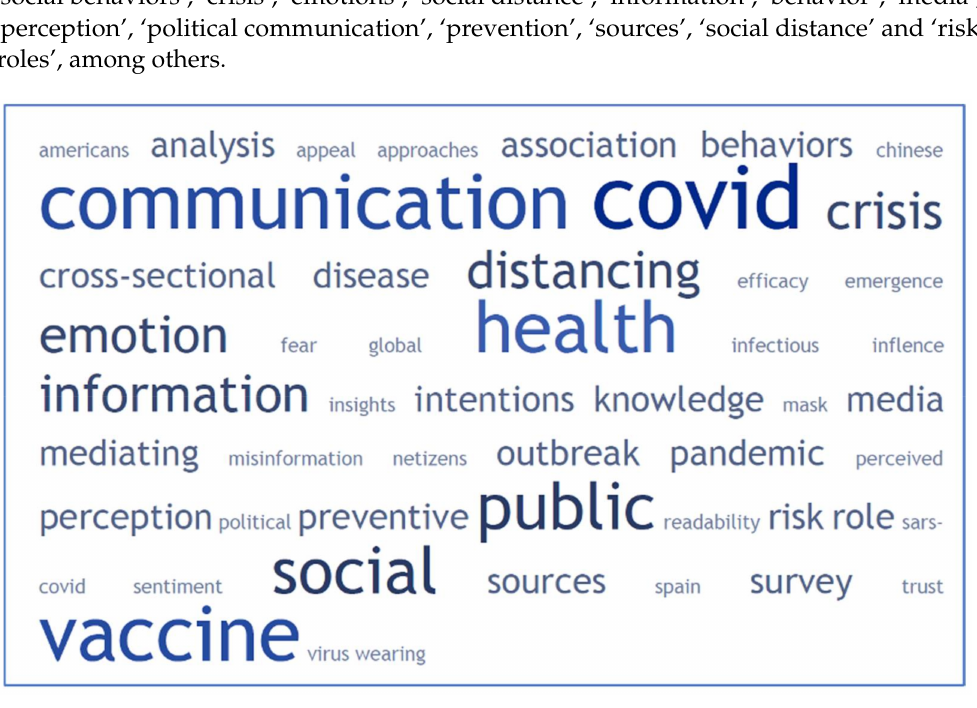
Figure 9. Predominant Word cloud in the scientific articles with the highest number of citations on COVID-19 and health